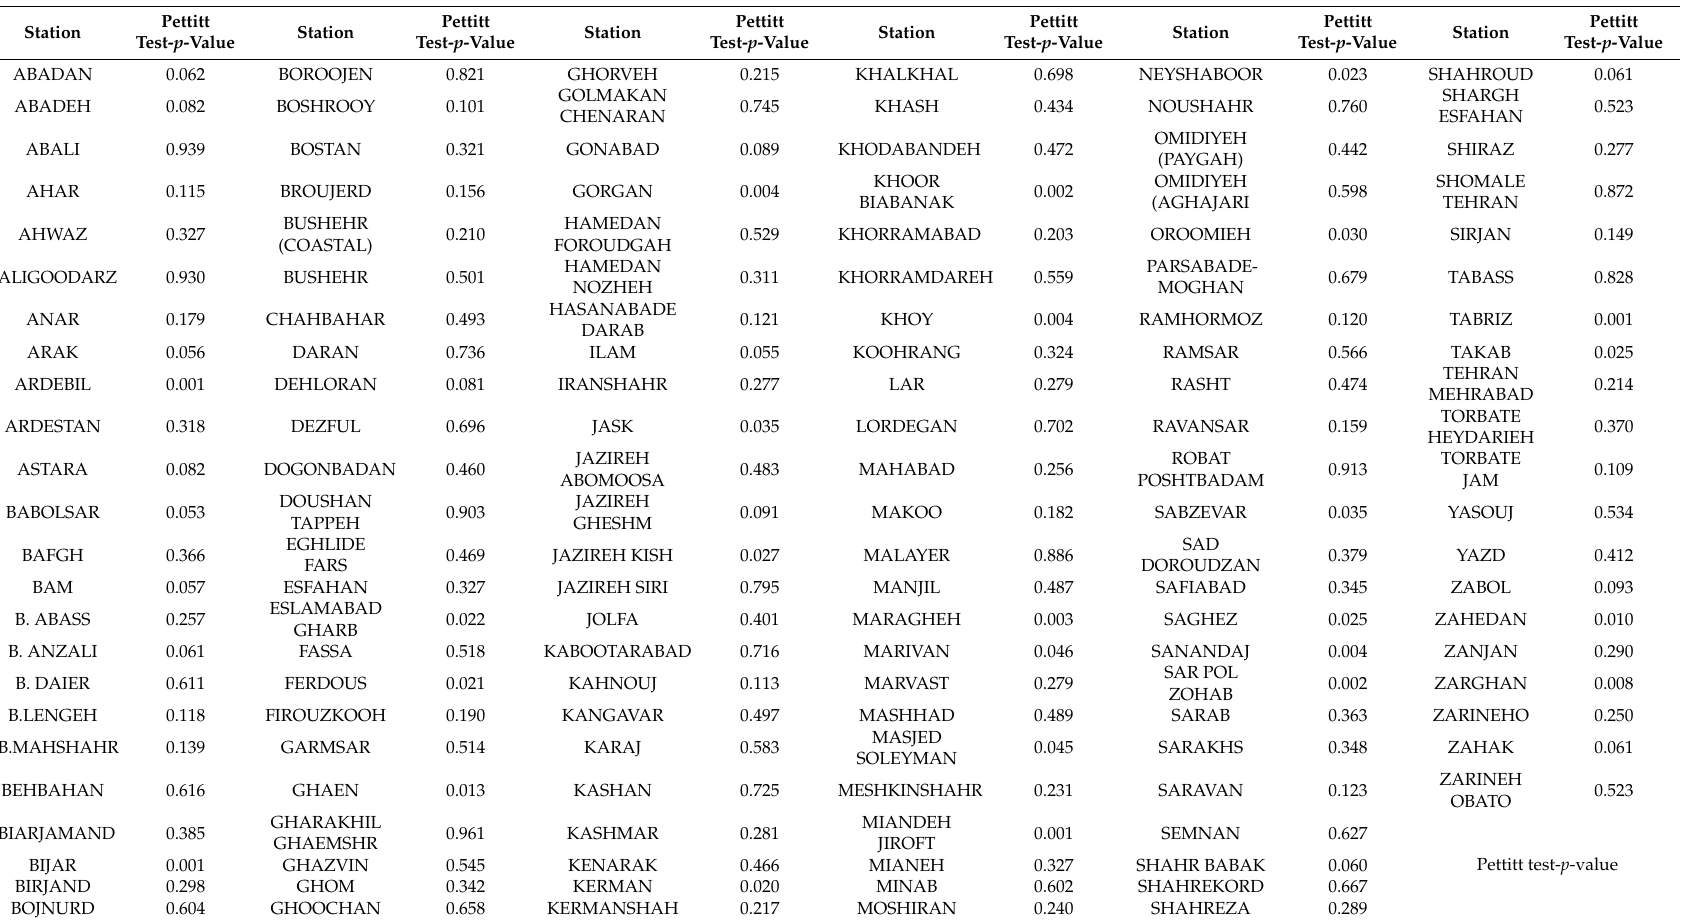
Table 1. Results of PWM test for rainfall in